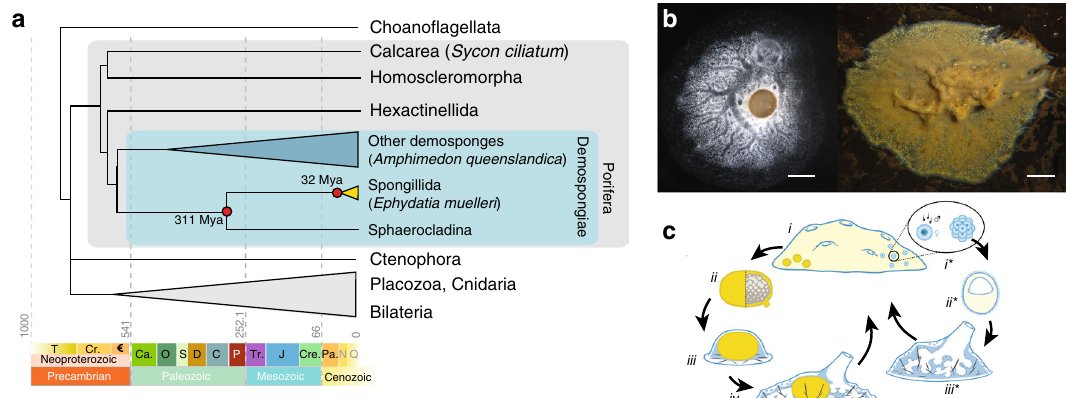
Fig. 1 Ephydatia muelleri biology and inter-relationships. a Diagrammatic cladogram of poriferan inter-relationships, showing fossil-calibrated divergence clock at bottom and at key nodes. These estimates of divergence were taken from prior analyses as shown in Supplementary Fig. 1. Tree is rooted with choano fl agellate species. Key clades and previously sequenced species are boxed and indicated. b Light microscope images of E. muelleri in culture and in situ (photos: S. Leys, scale 1 mm in left image, 1 cm at right). c Life cycle of E. muelleri , showing asexual (left) and sexual (right) modes of reproduction. Gemmules indicated as yellow dots in adult tissue. Asexual reproduction proceeds via hardy gemmules produced internally (i), which are separated from adults (ii), hatch and directly develop (iii) into adult tissue (iv). Sexual reproduction proceeds via generation of gametes (i*), embryonic development into a mobile parenchymella larva (ii*), and development as an independent adult (iii*).